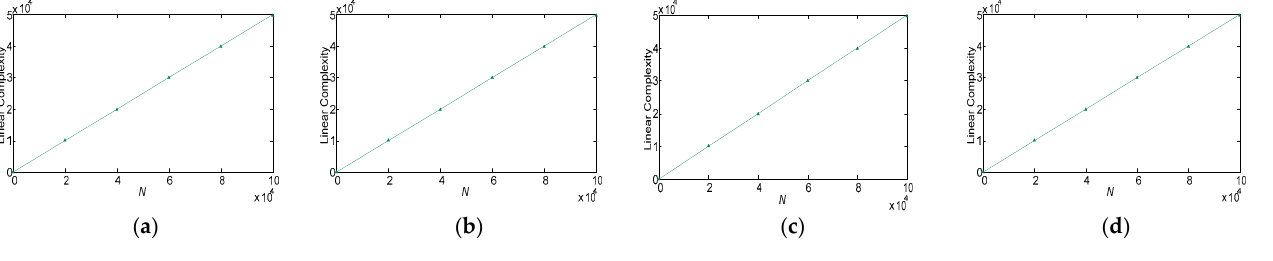
Figure 16. The linear complexity of the proposed improved CMLs. ( a ) The improved CML based on logistic map; ( b ) The improved CML based on tent map; ( c ) The improved compound CML, combining both the logistic map and tent map in a single stage; ( d ) The improved compound CML, combining the logistic map and tent map in an alternate stage.